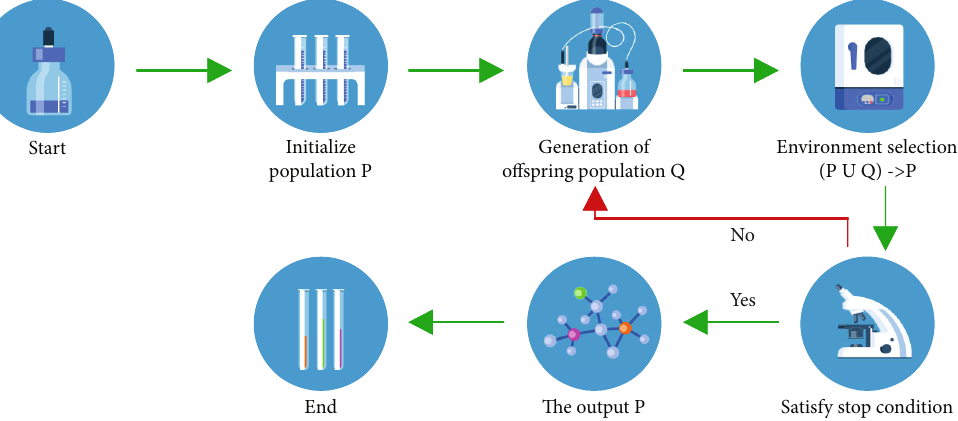
Figure 1: Multiobjective clustering algorithm of di ff erential evolution.